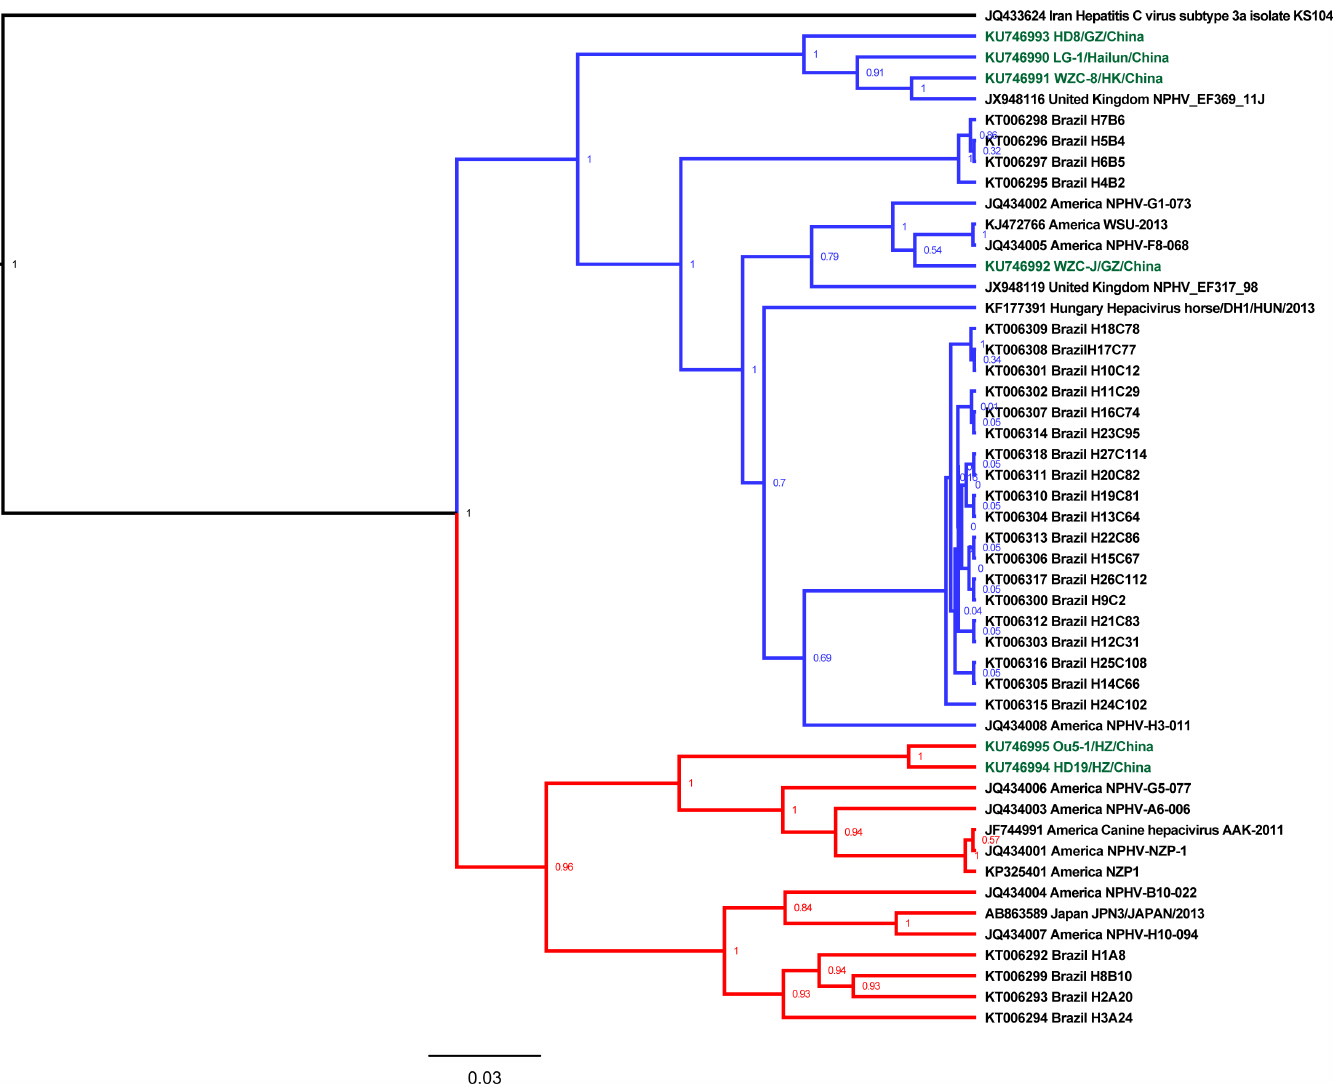
Fig 1. Phylogenetic analysis of the partial NS5B ORF sequences from EqHV. The field strains from China are indicated in green. Two distinct lineages for clades 1 and 2 are shown in blue and red, respectively. Details of the strain names, GenBank numbers and country names are indicated in the phylogenetic